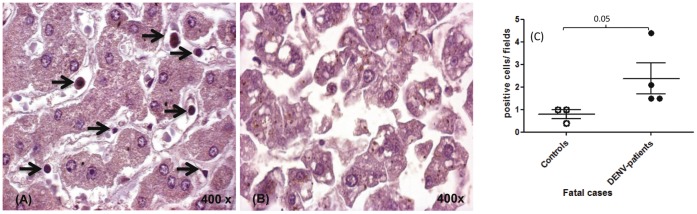
Detection of cells expressing the chemokine CCL5/RANTES in liver tissues from dengue fatal cases.Samples were incubated with CCL5/RANTES-specific antibodies and secondary horseradish peroxidase-conjugated antibodies, revealed with DAB. (A) Liver tissue of one dengue case reacted with CCL5/RANTES-specific antibodies. (B) One dengue case incubated with the secondary antibody only. (C) Quantification of the number of CCL5/RANTES positive cells in the four fatal dengue cases and three fatal non-dengue cases. CCL5/RANTES expressing cells were indicated by →. The Mann–Whitney U-test was used to analyze differences between control and patient groups. Statistically significant P values for differences between patients and controls are shown above the figures.